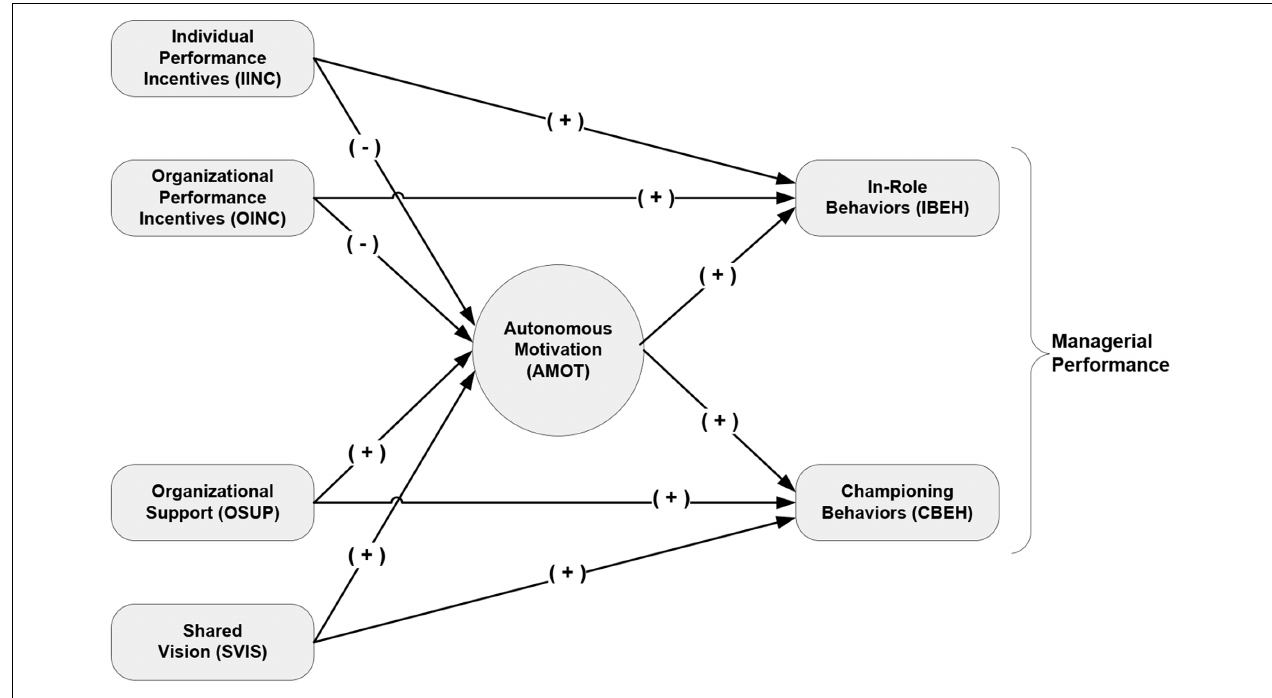
FIGURE 1 | Conceptual